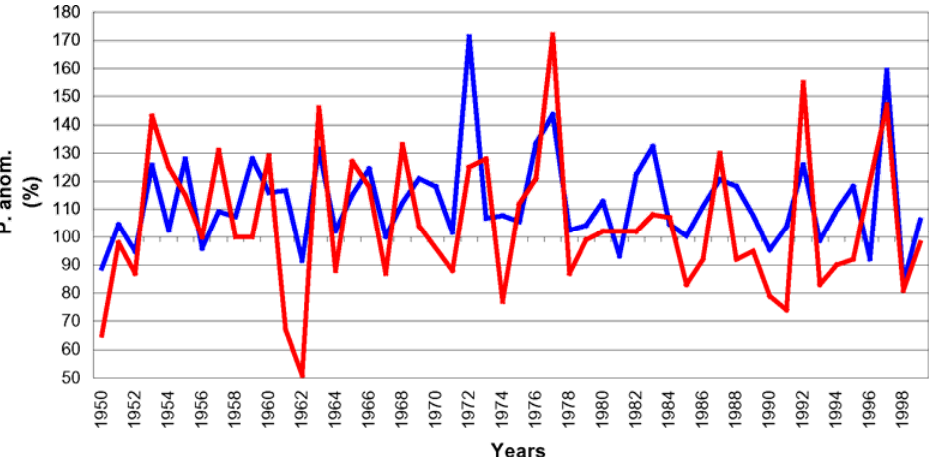
Figure 4. NN reconstruction (blue line) of the percentage precipitation anomalies in summer (red line) with respect to the mean of the period